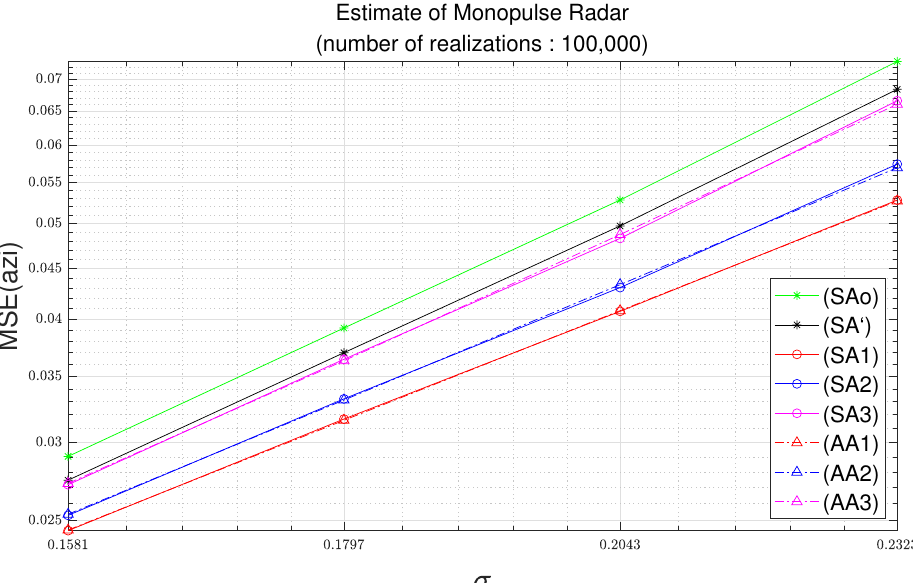
Figure 7. Azimuth MSE as function of standard deviation with parameters of Table 3 and 100,000